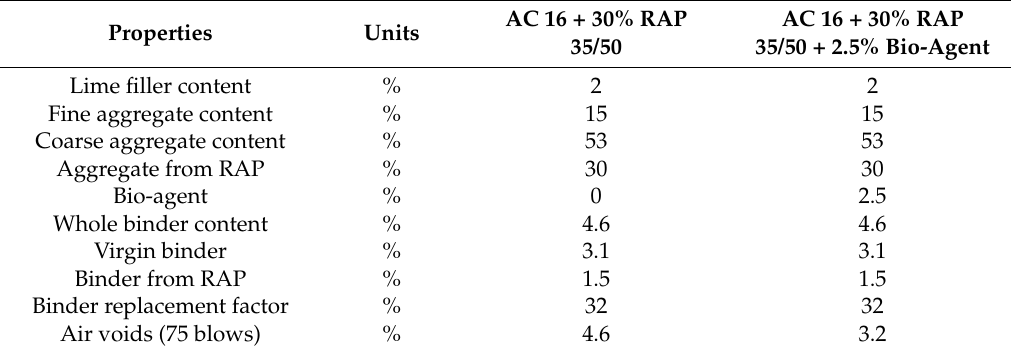
Table 1. Physical properties of asphalt